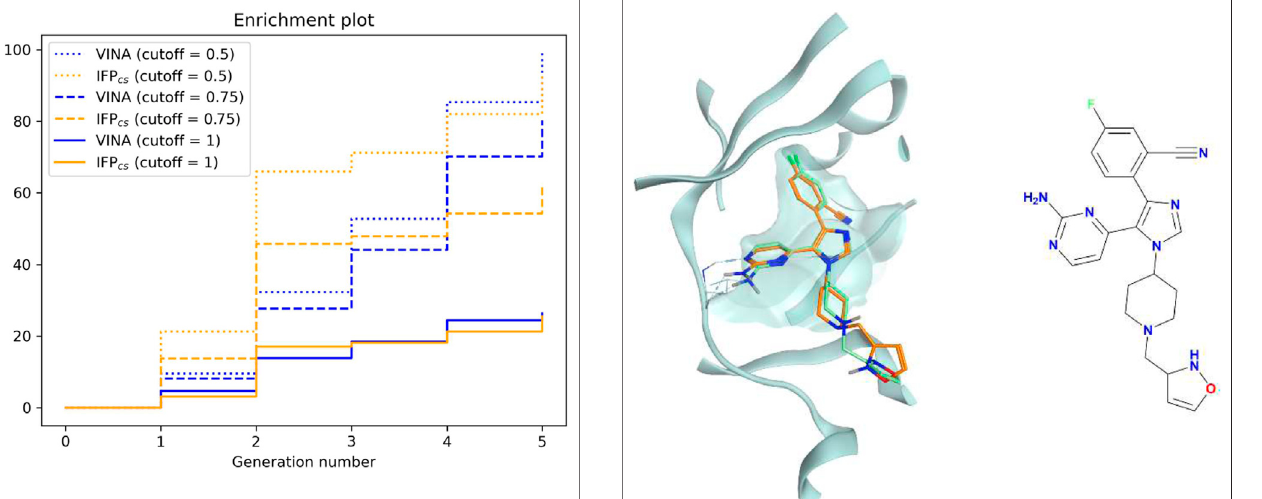
FIGURE 10 | The capability of the two different Autogrow protocols in the benchmark lead-optimizationrun toproducecompounds thathave ahigh degree of similarity concerning shape and electrostatic properties to the crystallographic ligands, chosen as reference. For each generation, the percentageofcompoundswithinthetotalpopulationwhose ET combo exceeds a de fi ned threshold value is reported. Three different cutoff values are reported: 0.50, 0.75, and 1.00, respectively.